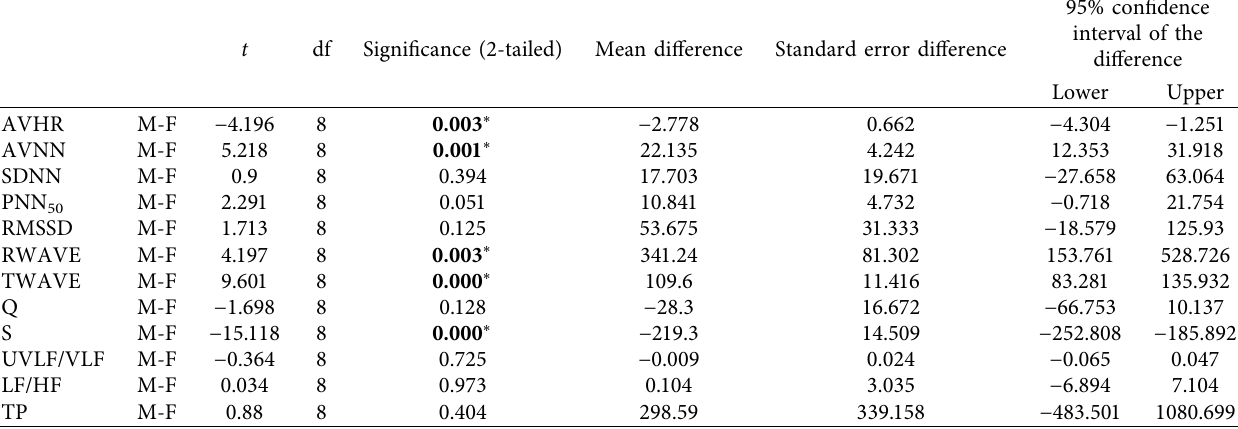
Table 6: Independent t -test results of ECG characteristics for male and female drivers in